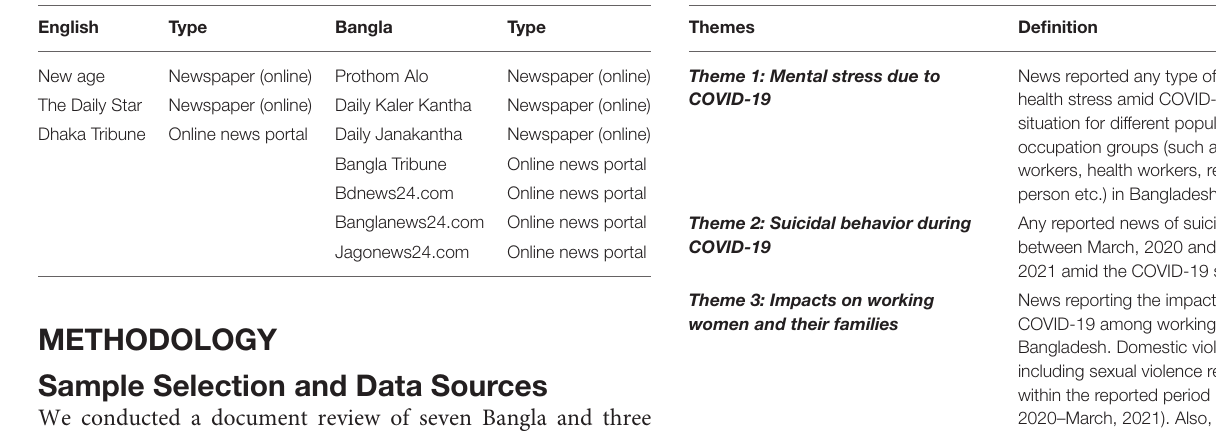
TABLE 1 | List of searched newspapers and news portals. TABLE 2 | Operational definitions of the themes from